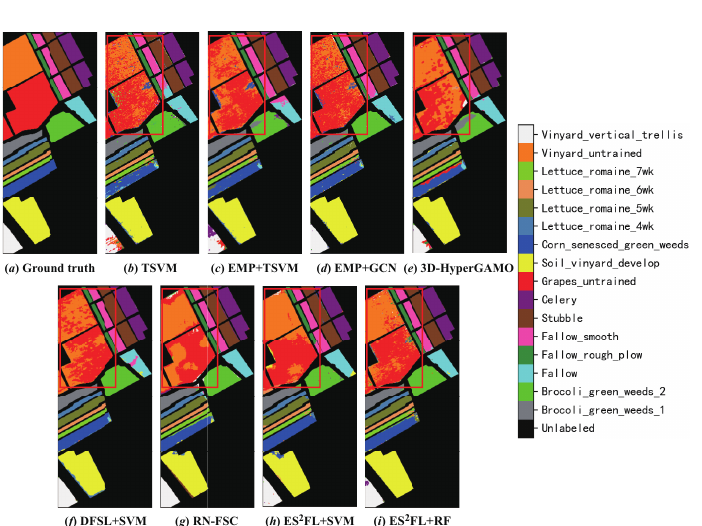
Figure 9. The classification maps resulting from different methods on the SA data set in the case of small